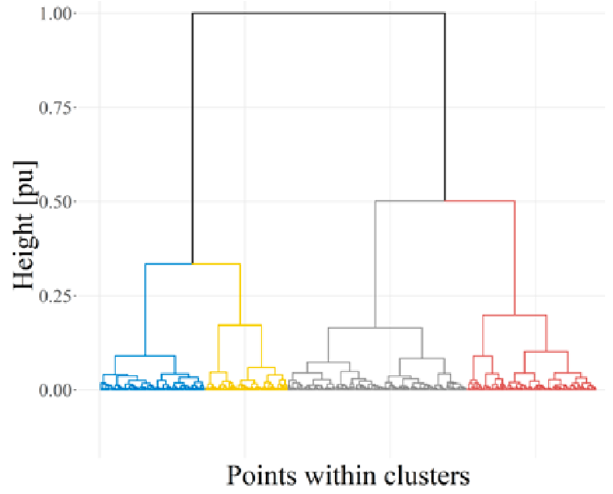
Figure 28. Dendrogram representation of the tree-like structure obtained with the hierarchical agglomerative algorithm [22].